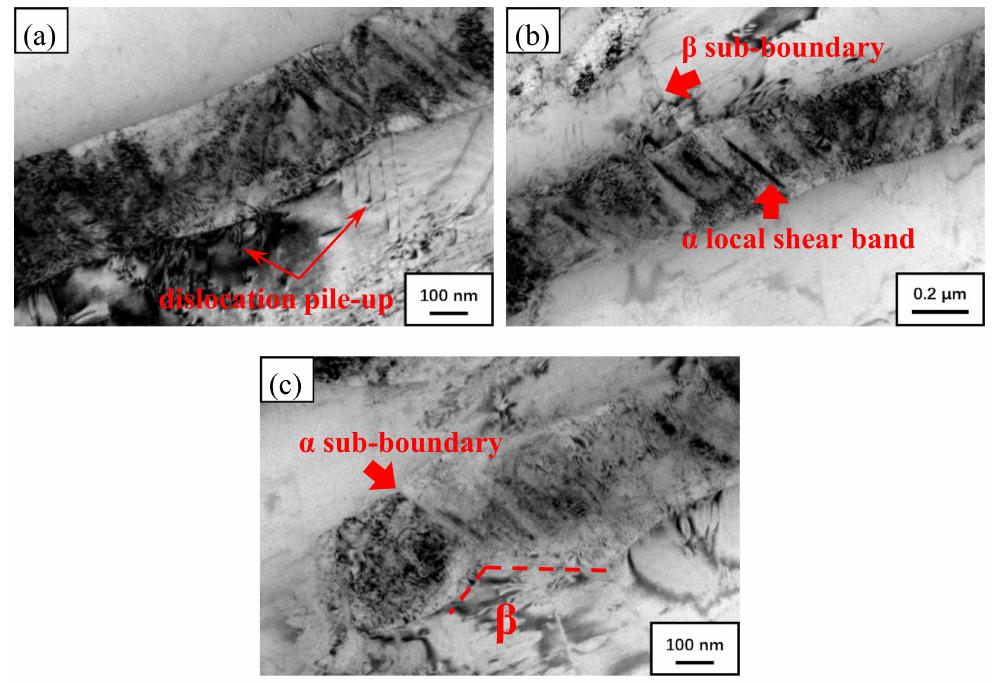
Figure 9. TEM graphs of microstructure evolution without the Burgers orientation relationship between the neighboring β and α : ( a ) piling-up of dislocations at the α / β interface at the strain of 0.1; ( b ) formation of local shear bands in acicular α at the strain of 0.4; and ( c ) hedging of the β phase into the acicular α phase along the interface among shear